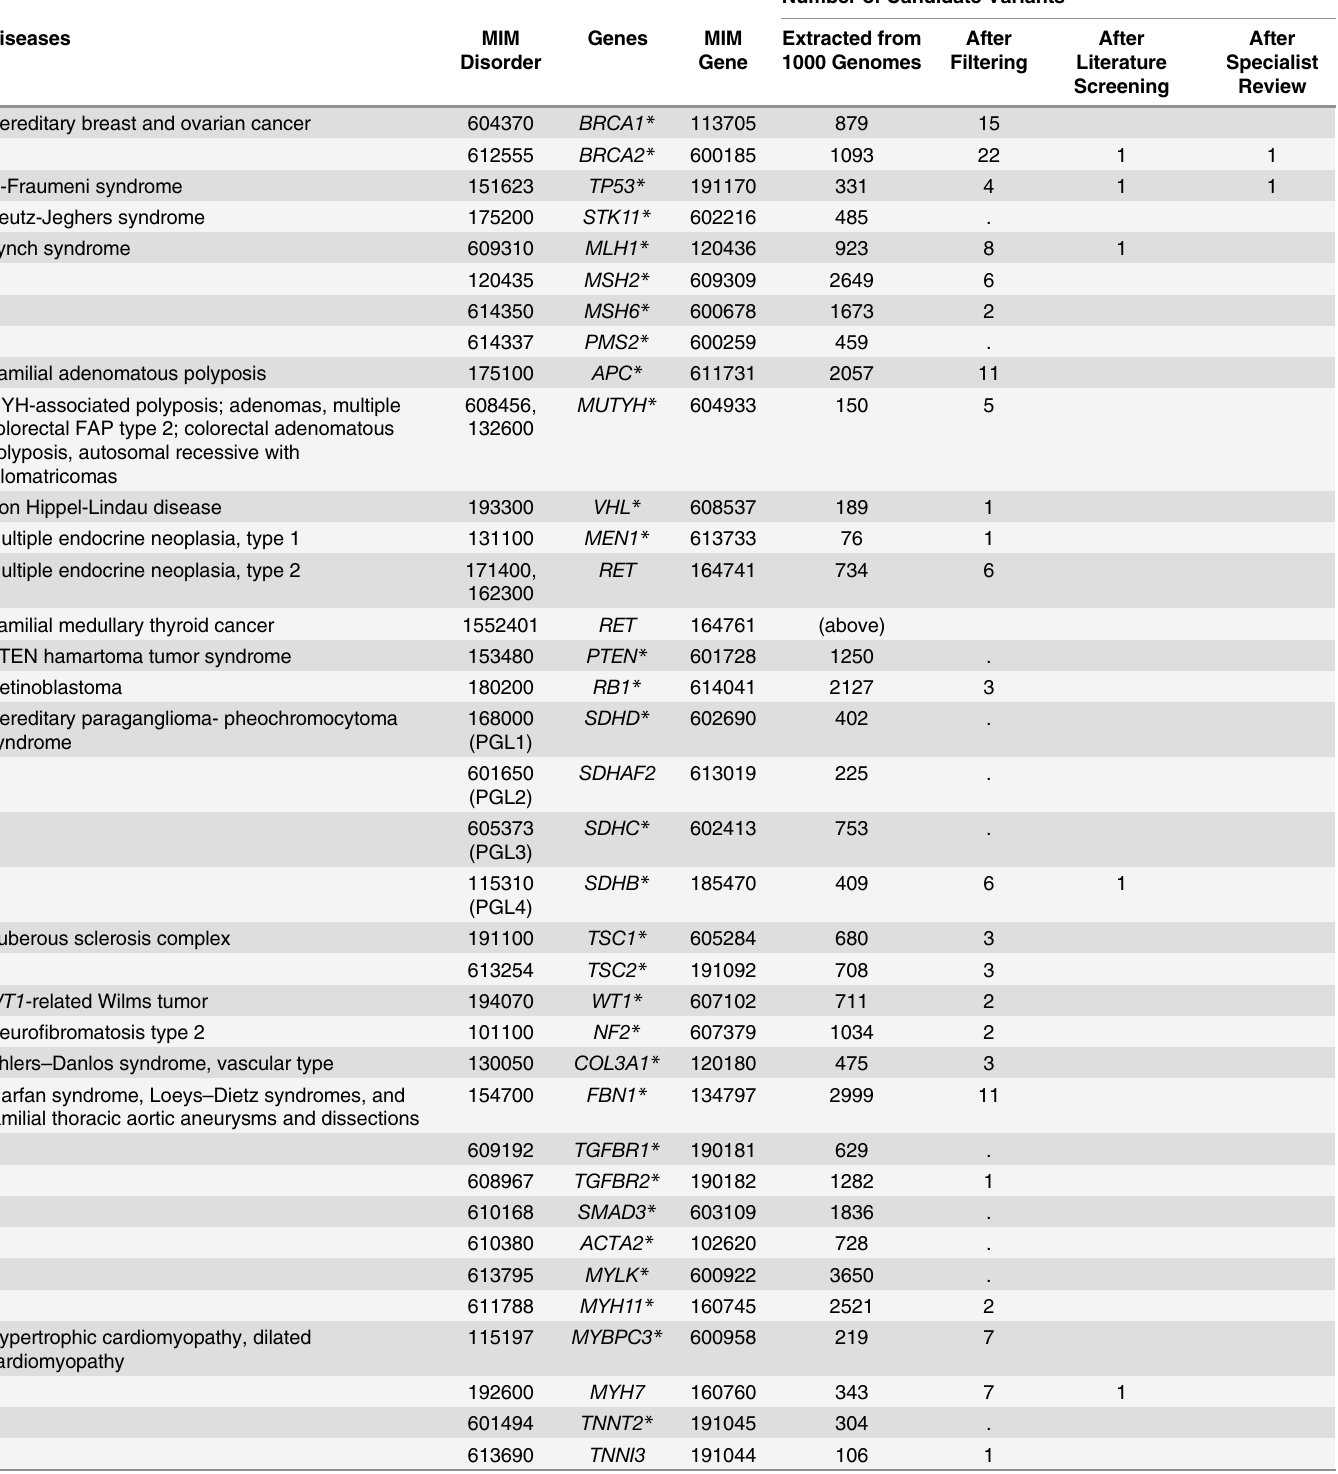
Table 1. Number of candidate variants after different review